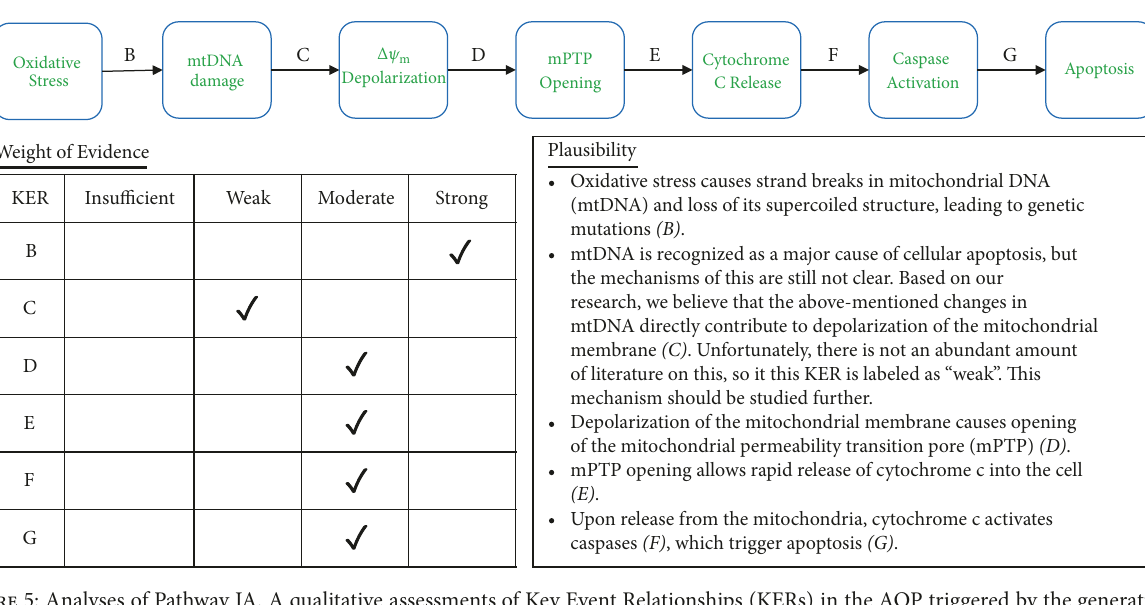
Figure 5: Analyses of Pathway IA. A qualitative assessments of Key Event Relationships (KERs) in the AOP triggered by the generation of reactive oxygen species (MIE) and resulting in mitochondrial disease (AO) via KERs B, C, D, E, F, and G.